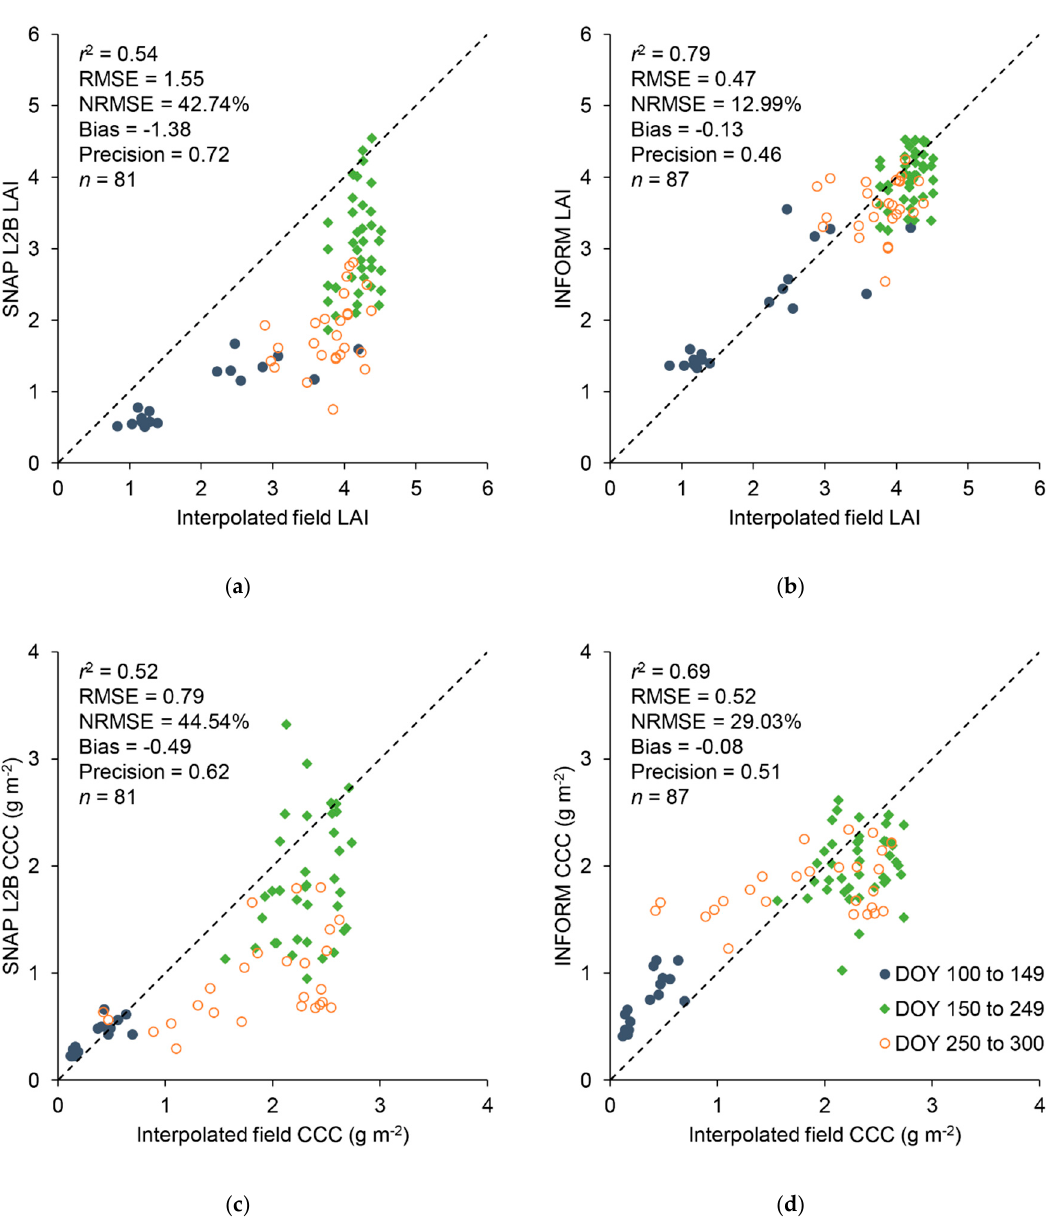
Figure 4. Comparison between interpolated field data and LAI ( a , b ) and CCC ( c , d ) retrievals from the SNAP L2B ( left ) and INFORM-based ( right ) retrieval algorithms. Points represent measurements at the ESU level, dashed lines represent a 1:1 relationship. Table 5. Performance statistics for the SNAP L2B and INFORM-based retrieval algorithms when evaluated against interpolated field data, by phenological subset.